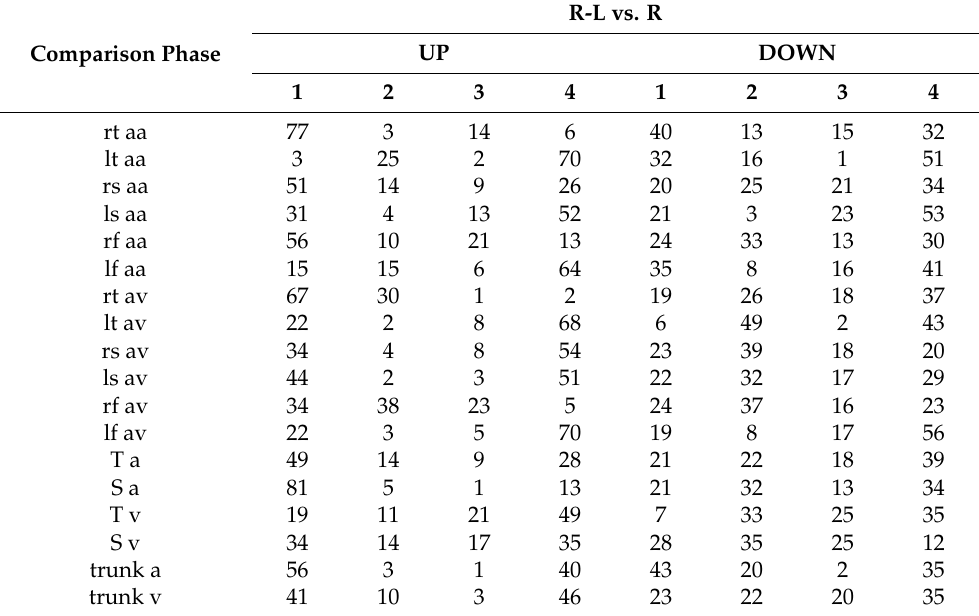
Table 7. Percentage of the significant difference points in each gait phase of each parameter (%).